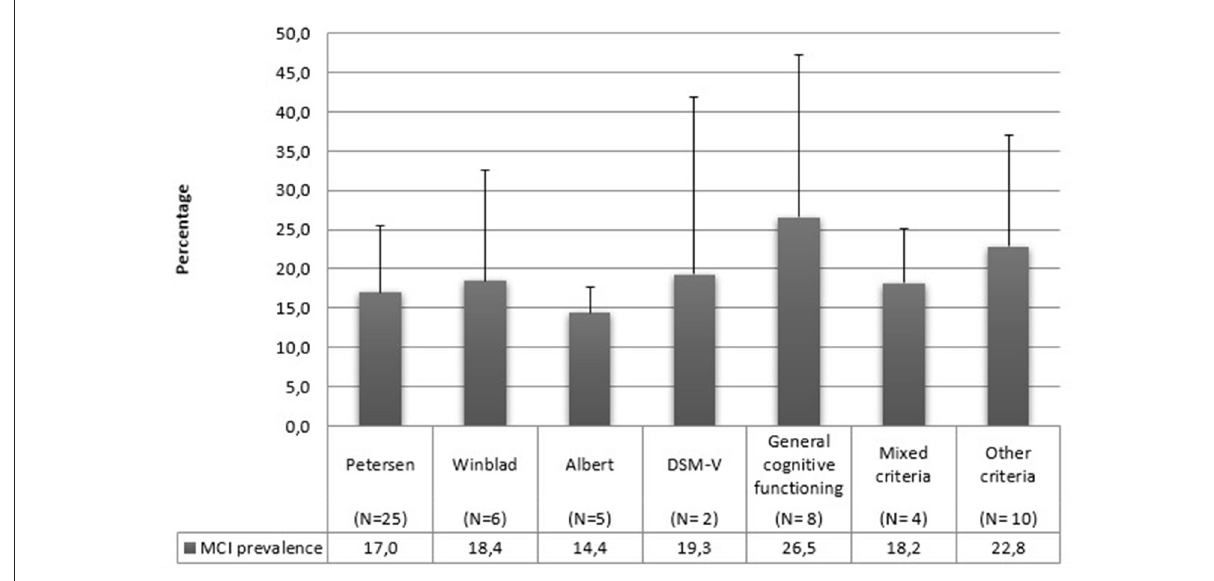
FIGURE5 MCI mean prevalence rates according to diagnostic criteria.